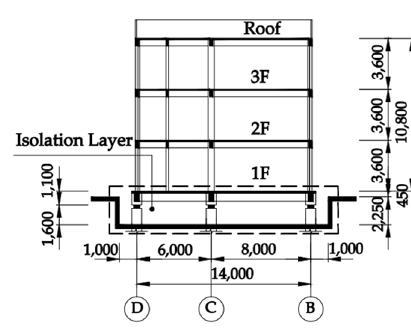
Figure 2. Profile 1-1 (Unit: mm).